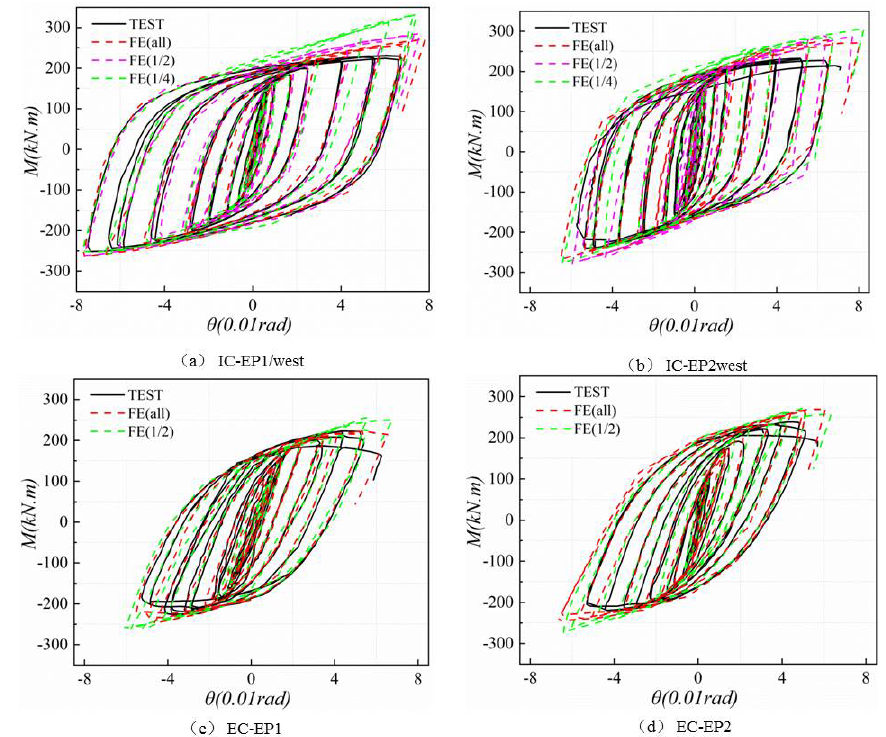
Figure 19. Comparison between experimental and FE results for the four tested specimens. ( a ) IC-EP1 / west; ( b ) IC-EP2west; ( c ) EC-EP1; ( d )